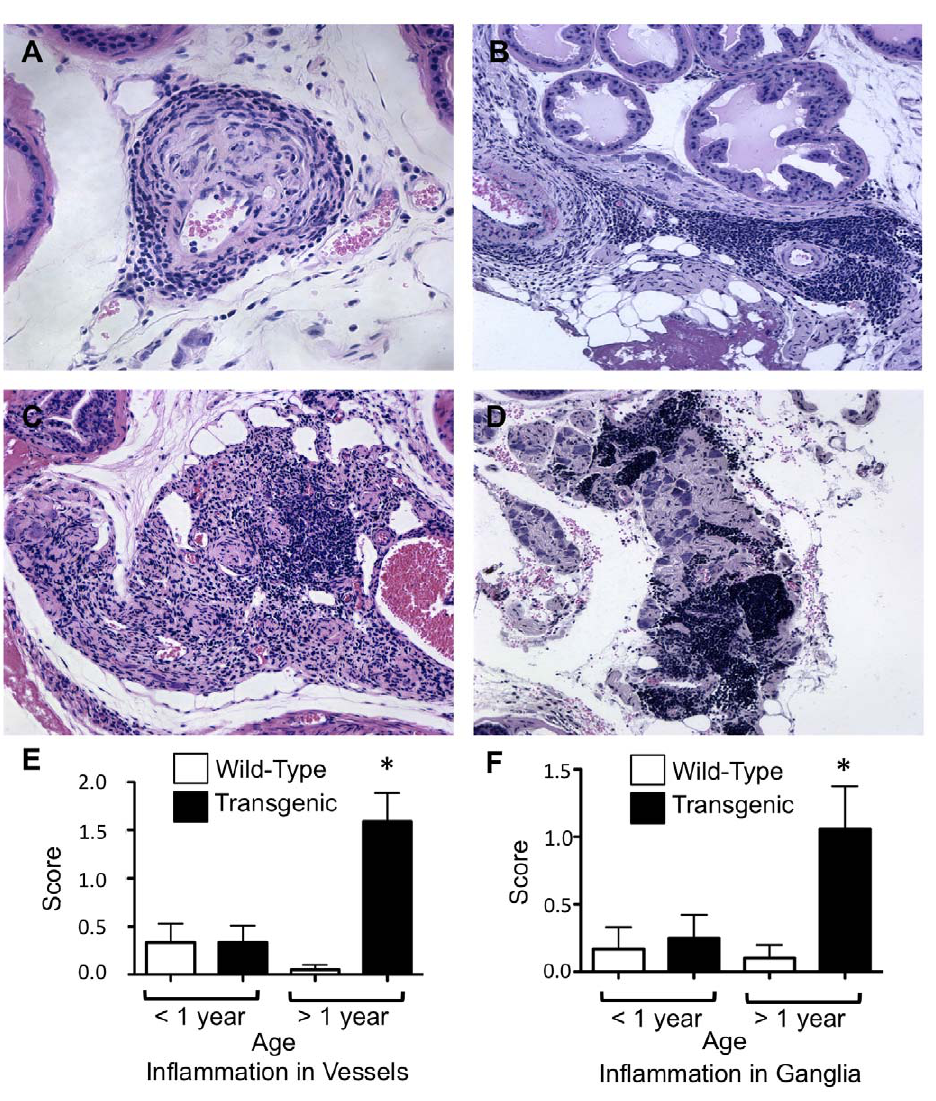
Figure 3. Inflammation is increased in an age-dependent manner in nerve ganglia and associated vasculature of TGF- b 1 transgenic mice. PanelA. Vascular fibroplasia is evident in the wall of some vessels. PanelB. Focal regions of inflammation characterized by accumulations of immune cells is observed adjacent to some vessels in an age-dependent manner. PanelCandD. Peripheral inflammation appears within most prostatic interlobar parasympathetic ganglia and neurovascular bundles in transgenic mice. PanelsEandF . Quantitation yields significantly greater inflammation in aged transgenic compared to wild-type vessels and ganglia, respectively ( P , 0.05). All images captured at 6 200 magnification.